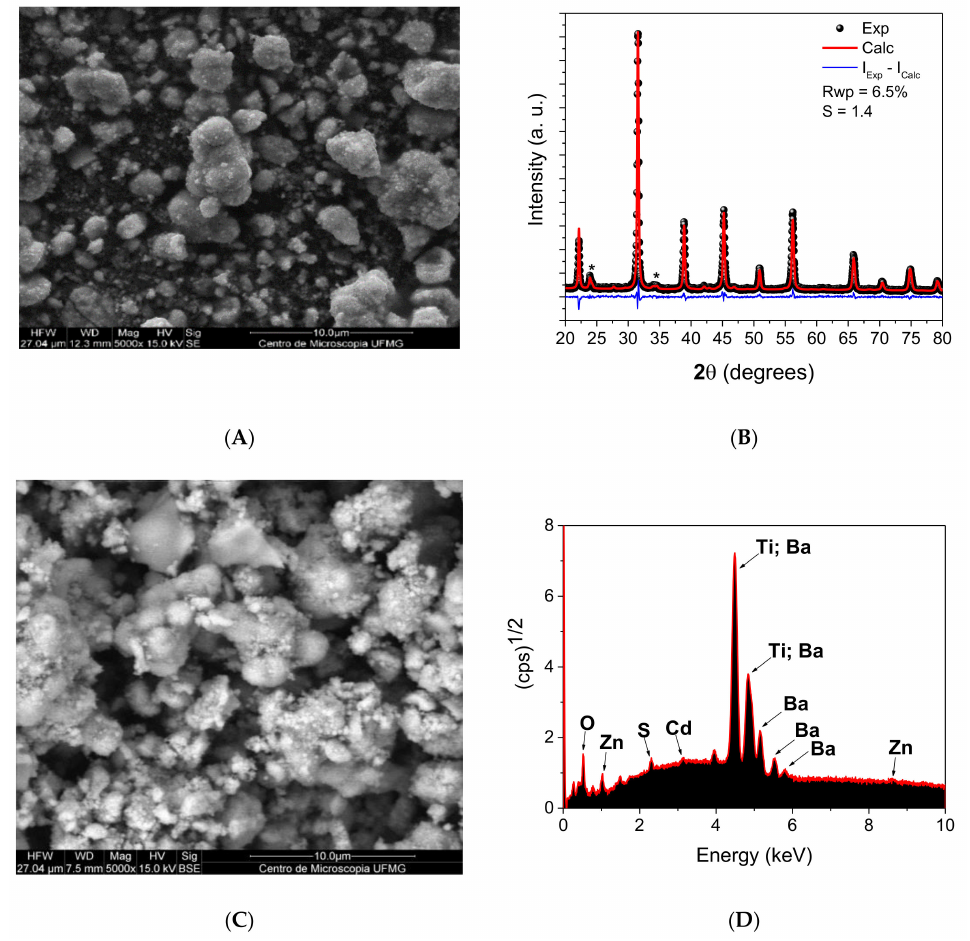
Figure 1. ( A ) SEM image for the BTO or BaTiO 3 perovskite at a magnification of 5000 × ; ( B ) XRD patterns, with Rietveld refinement, for BTO; ( C ) SEM image for the CdSeS/ZnSQDs/BTO material at a magnification of 5000 × ; ( D ) EDX spectrum of the CdSeS/ZnSQDs/BTO